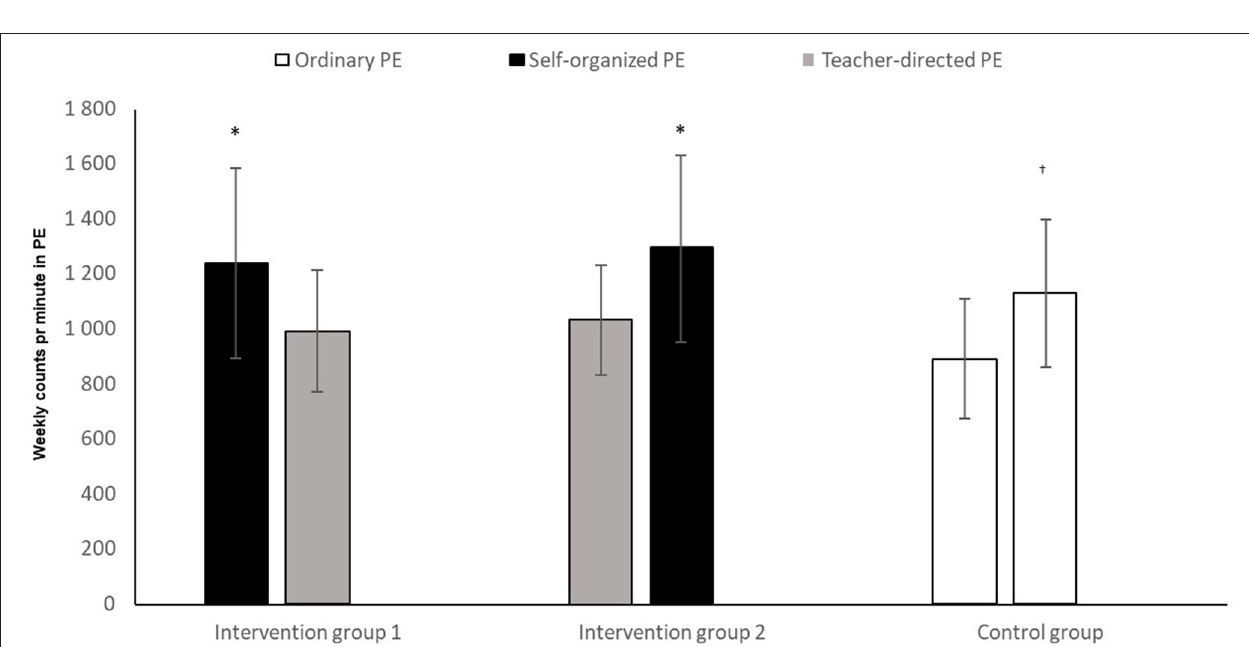
FIGURE 7 | Level of PA among pupils in two time periods of ordinary PE, teacher-directed PE, and self-determined PE. *Significantly higher level of PA with self-determination compared to teacher-directed instruction ( p < 0.05). † Significantly higher level of activity in T2, compared to T1 ( p < 0.05).